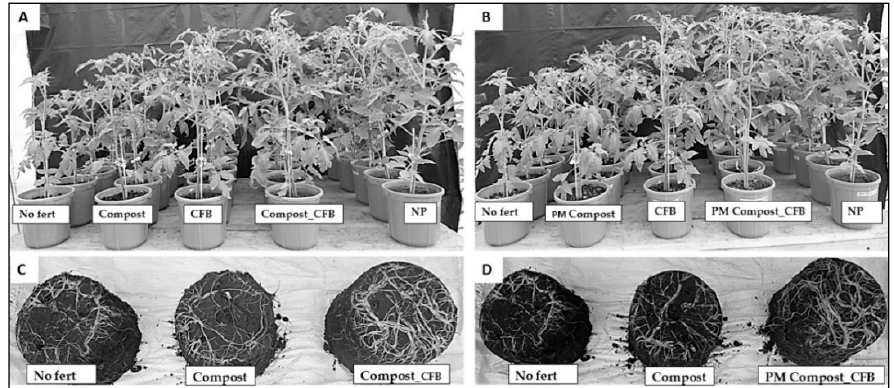
Figure 1. ( A ) Plant growth of 7-week-old tomatoes on pH 7.8 soil supplied with CFB and compost, mineral NPK fertilization (NP) or without fertilization; ( B ) CFB and PM compost; and root development with ( C ) CFB and compost; ( D ) CFB and PM compost. (CFB = Combifector B, PM = poultry manure, NP = calcium nitrate plus superphosphate, Nofert = unfertilized).